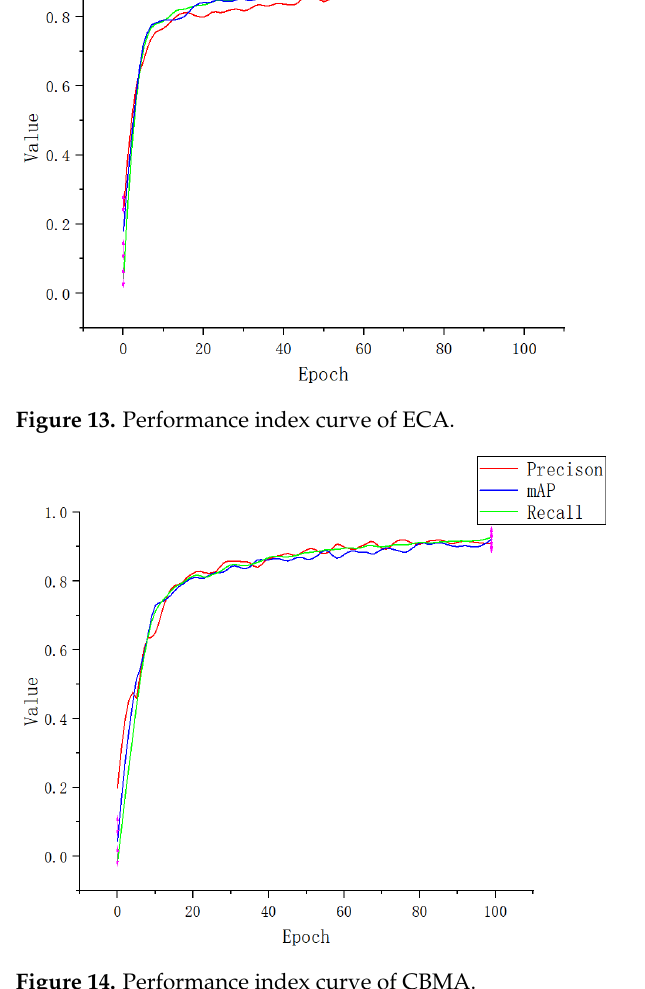
Figure 14. Performance index curve of CBMA.